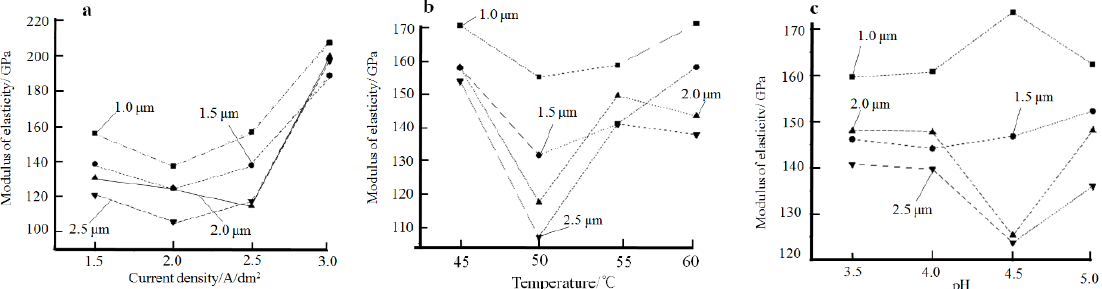
Figure 8. Effect of plating parameters on the elastic modulus of the plated layer: ( a ) current density, ( b ) temperature of the plating solution, ( c ) pH.